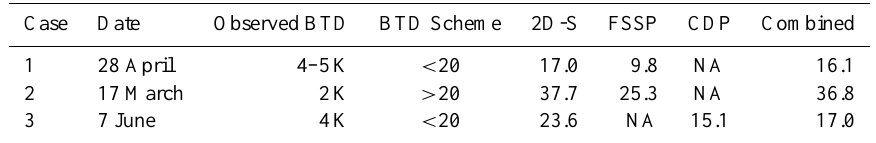
Table 1. Estimated effective radius in µm from SPEC 25 Learjet in-situ instrumentation and infrared BTD threshold scheme for three MODIS overpass test cases observed during SPartICus.